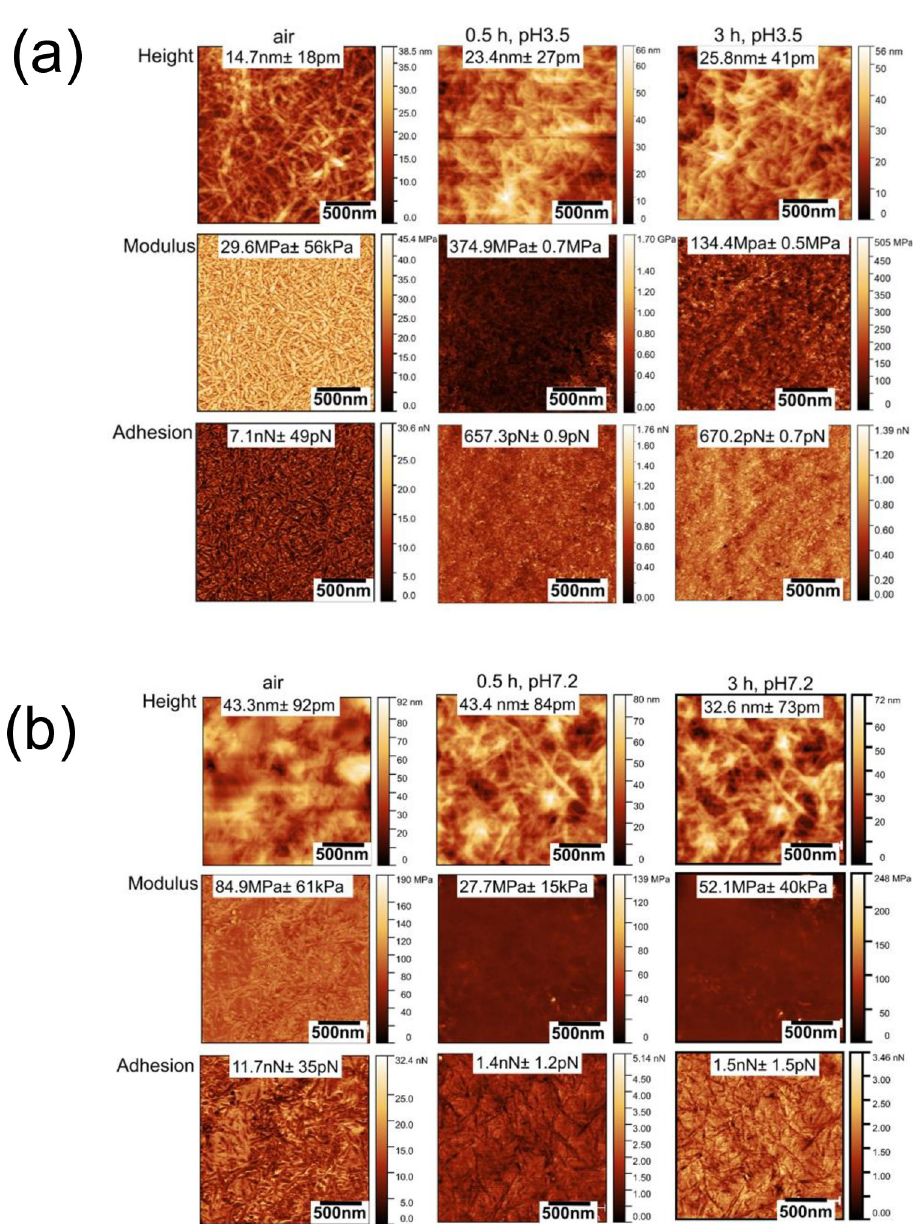
Fig 4. Sequential PFQNM images of TCNFs obtained in air and then in PBS buffer after 30 minutes after 3 hours of immersion at pH 3.5 (panel (a)) and pH 7.2 (panel (b)). (scale bar: 500 nm).